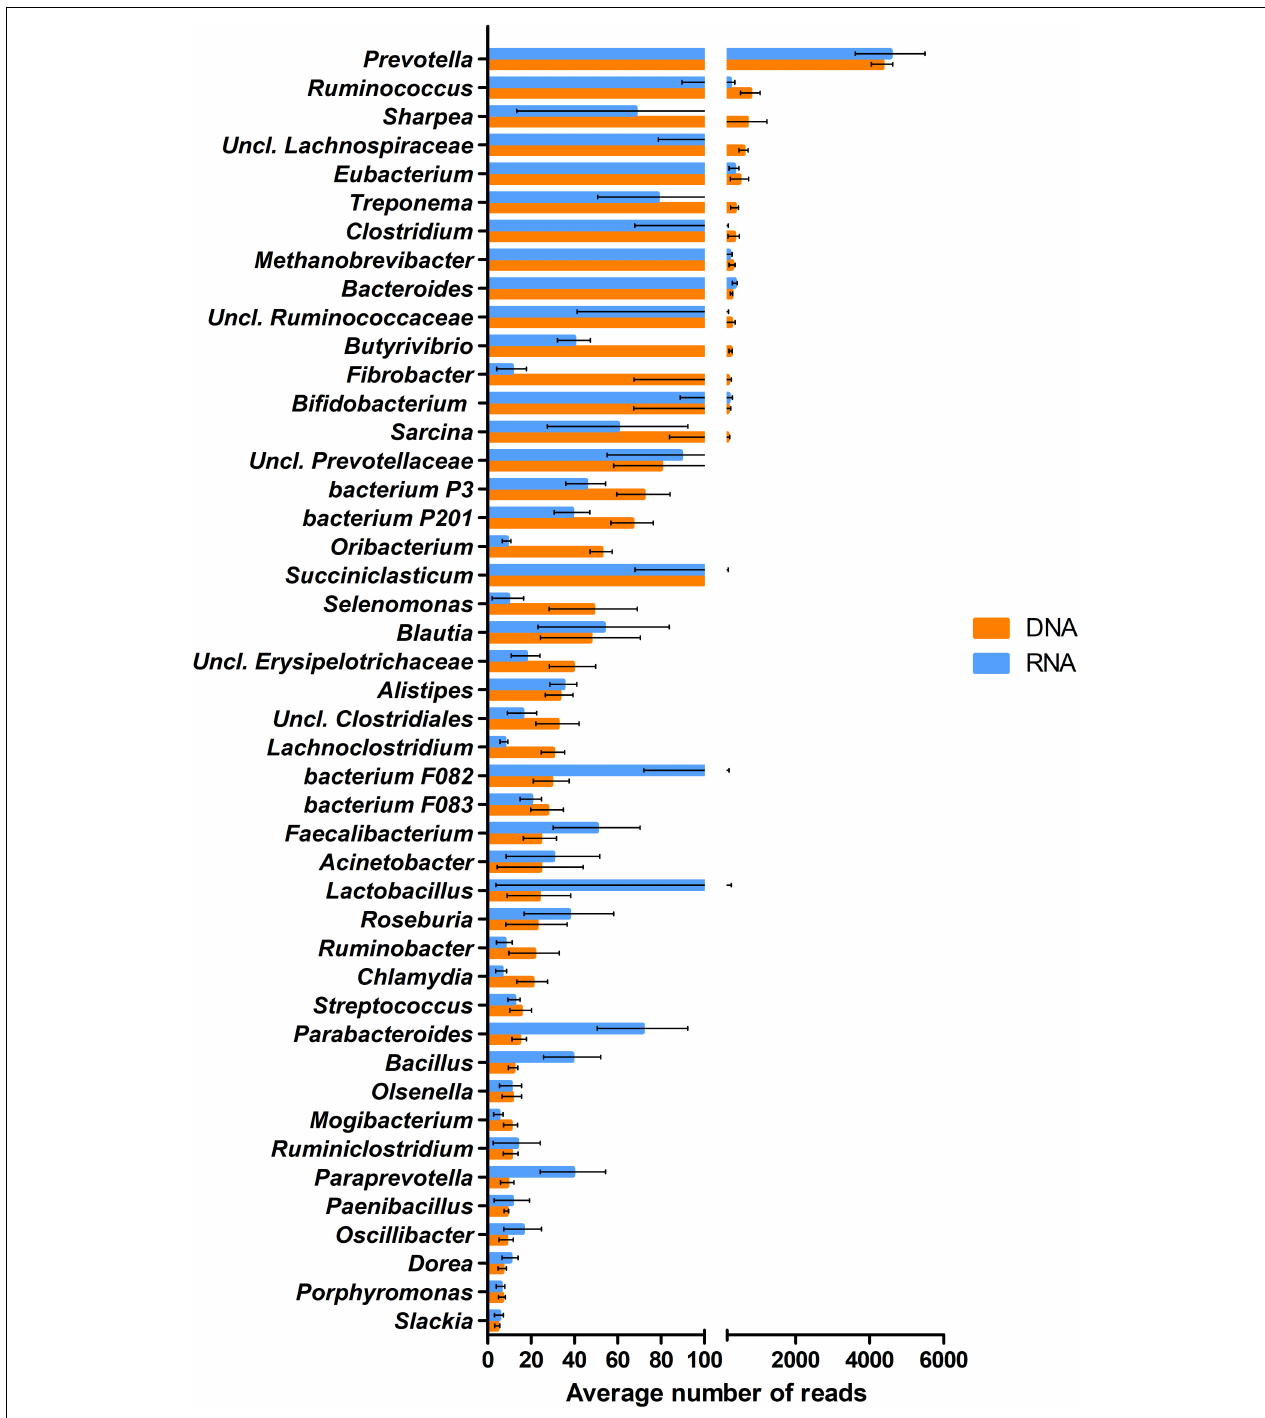
FIGURE 2 | The abundance distribution of the 48 genera comprising the core microbiota calculated from the average DNA-based metagenome and RNA-based metatranscriptome datasets. Error bars indicate the variances among the individual 10 rumen samples.